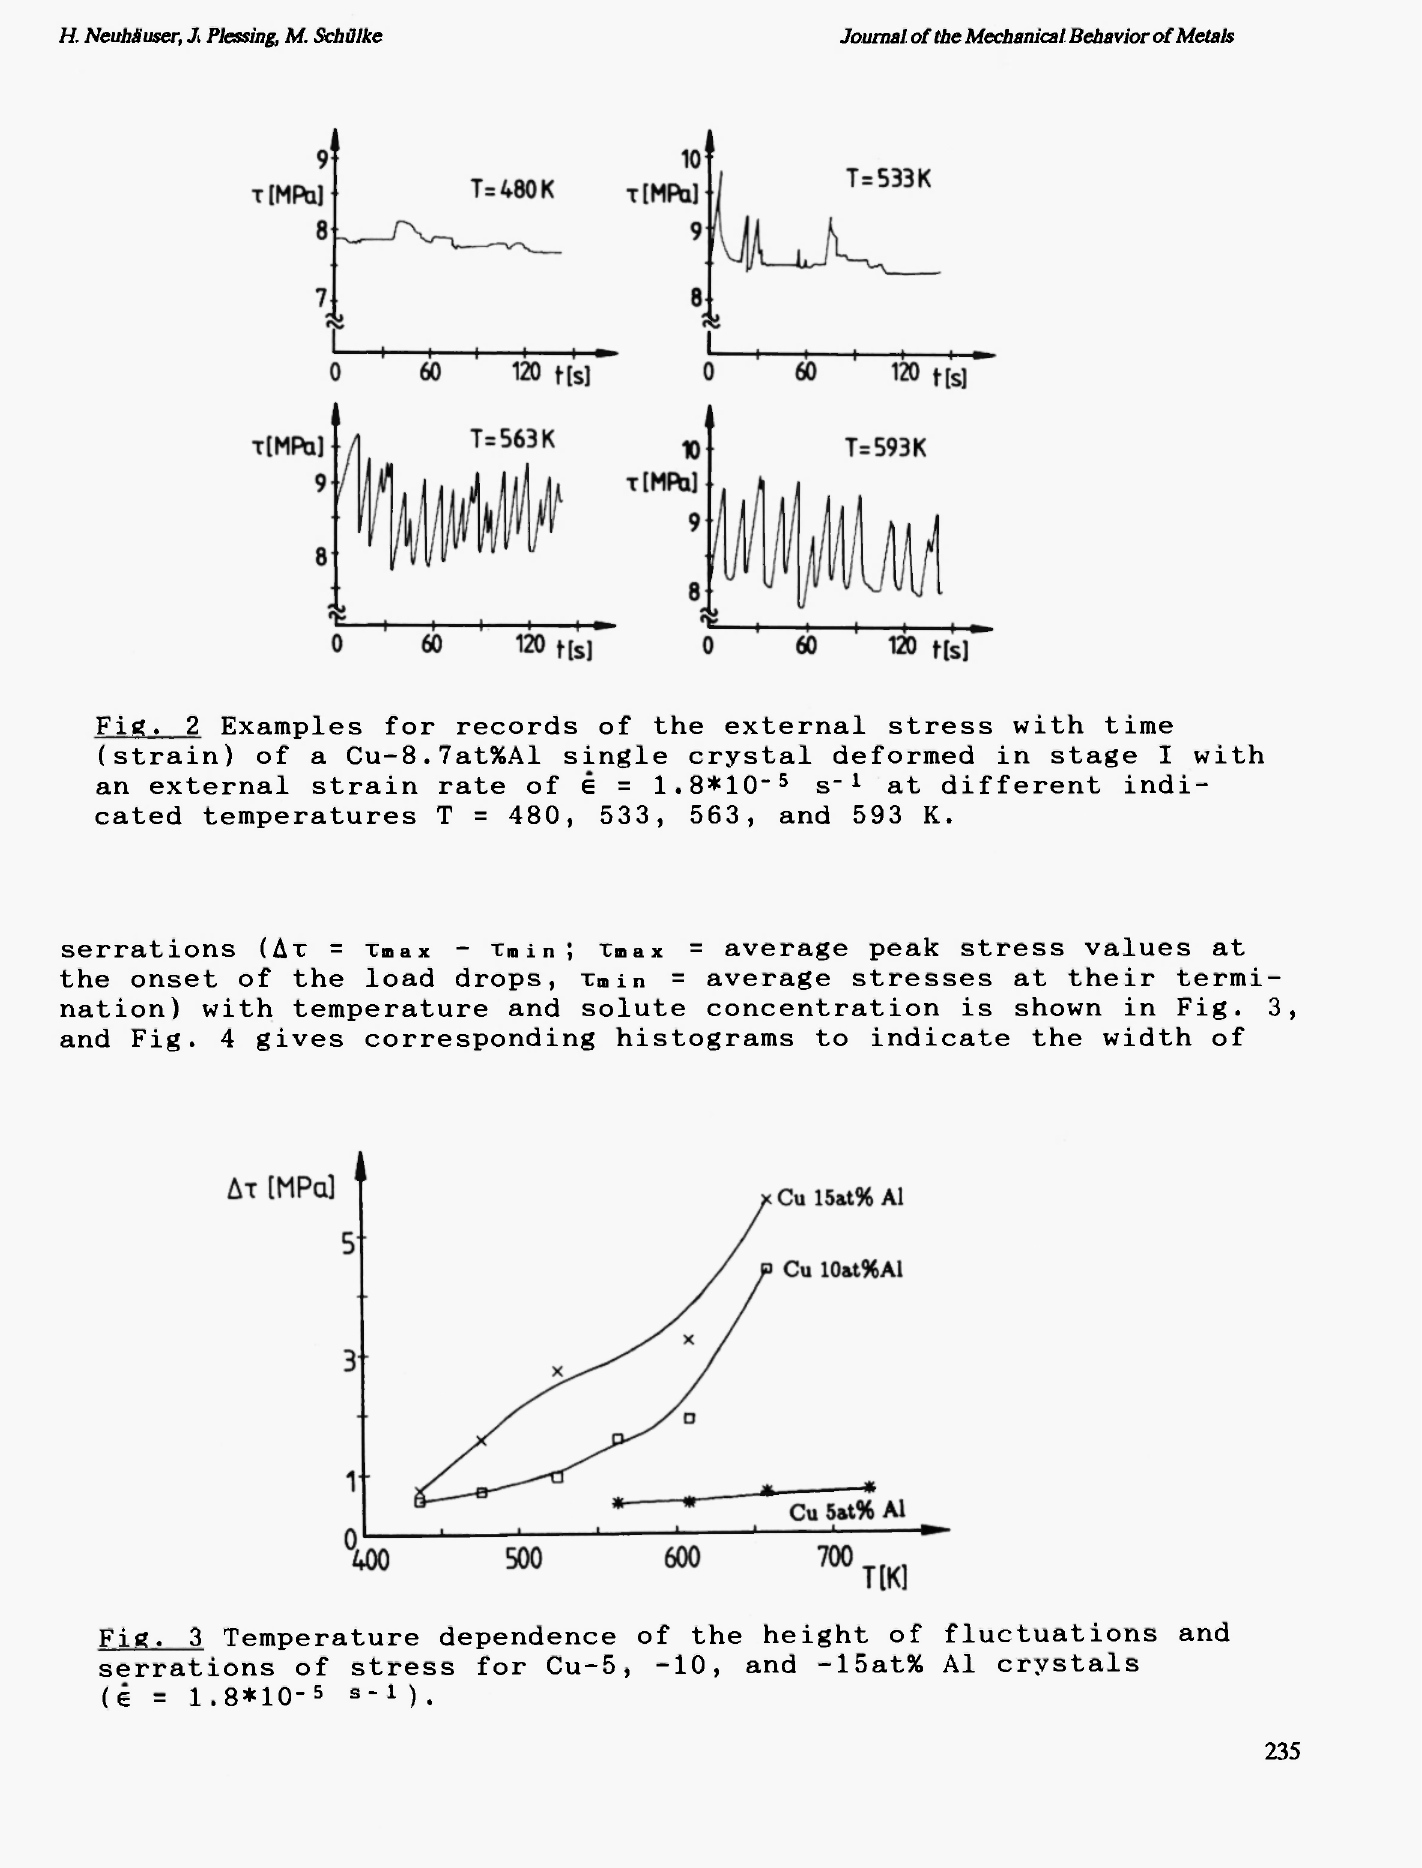
Fig. 3 Temperature dependence of the height of fluctuations and serrations of stress for Cu-5, -10, and -15at% Al crystals (6 = 1.8*10" 5 s " 1 )